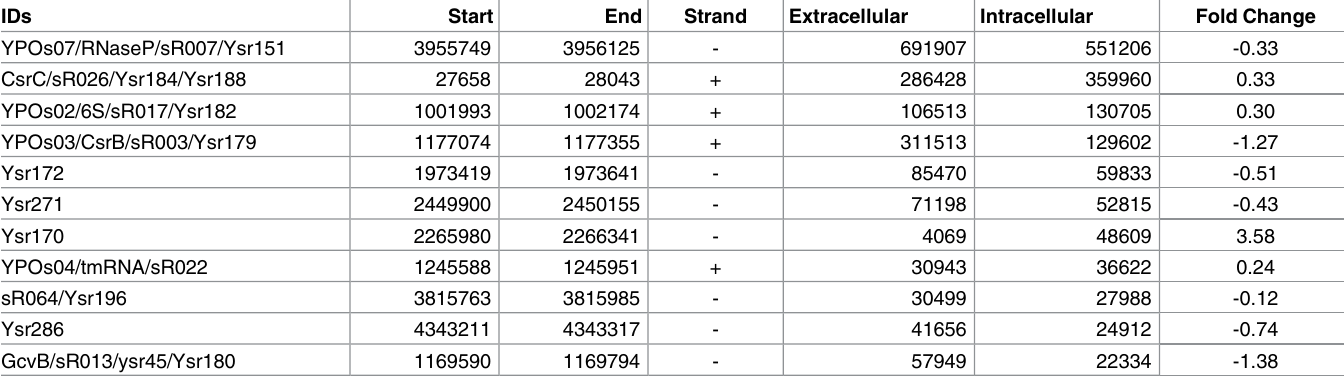
Table 1. List of small RNAs with mean normalized counts > 20000 in the intracellular